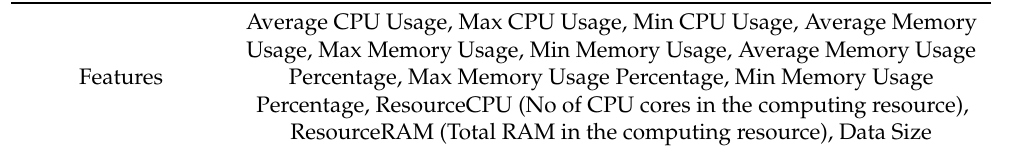
Table 2. Features of task sizing measurement data.